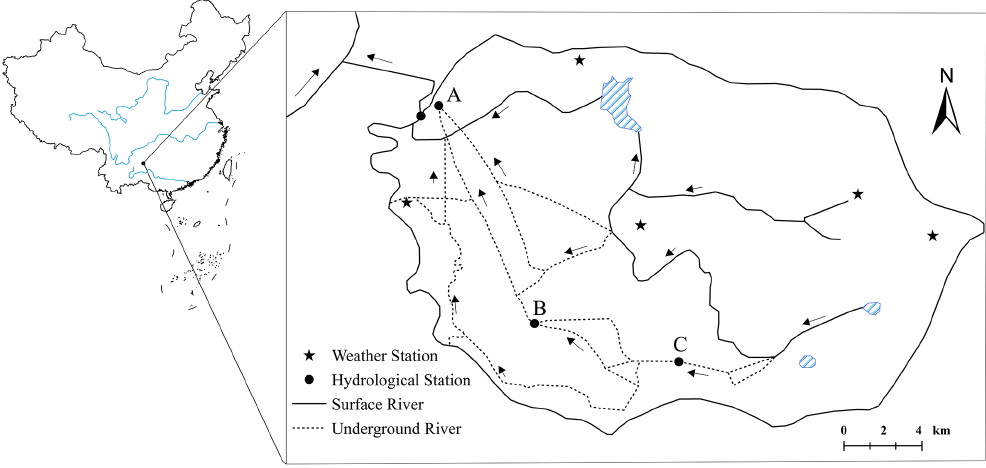
Figure 1. The distribution of drainage systems and weather hydrological stations. Table 1. The proportion of different land cover types and characteristics of underground river chemicals in the west and east banks of Dagou River. Region